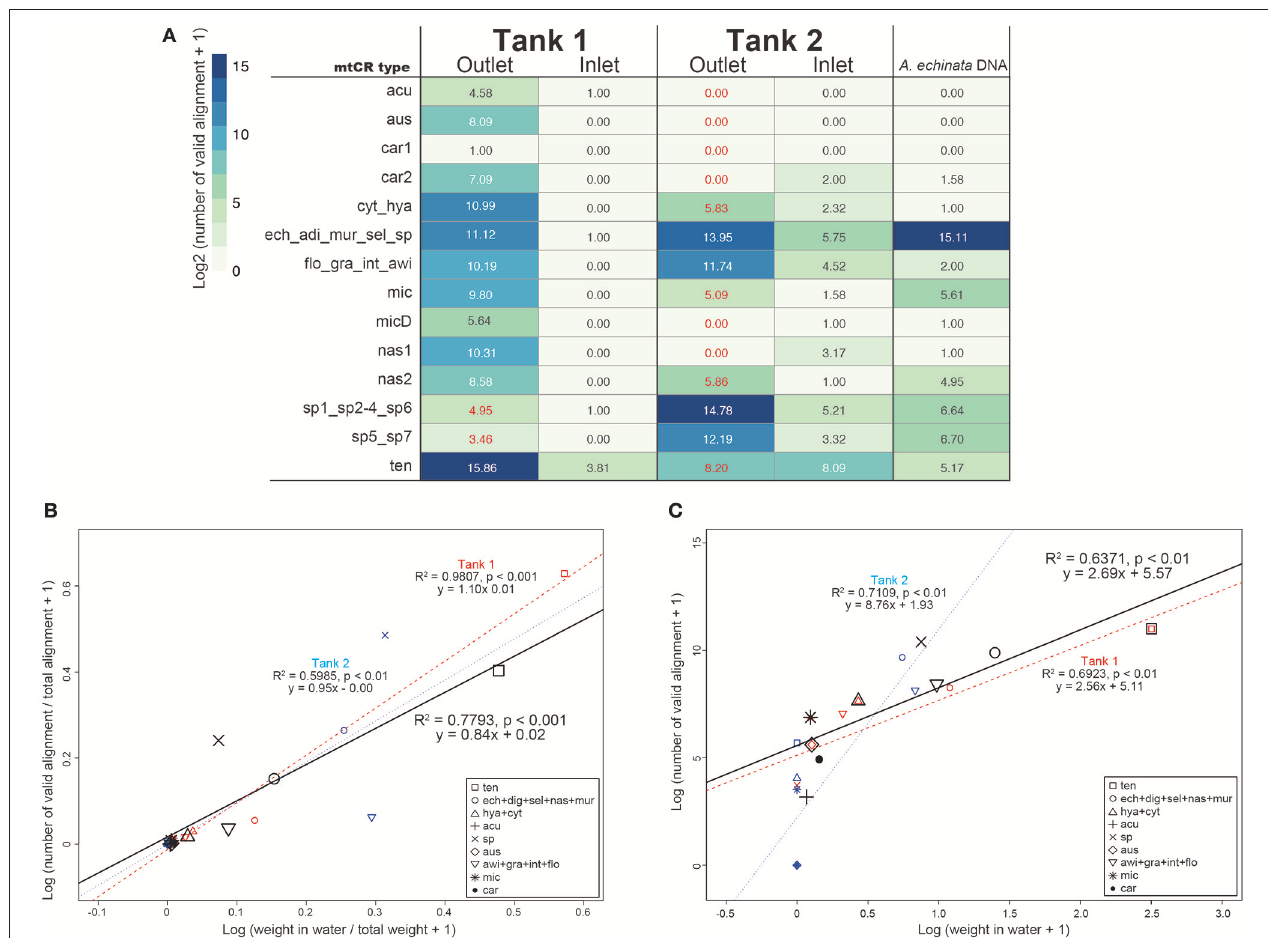
FIGURE 3 | (A) The number of Acropora mtCR types detected from eDNA and Acropora echinata DNA as a positive control. Numbers of valid alignment are shown at log2 scale and colored. IDs of the 300 bp flanking the RNS2 primer sequence in the mtCR are identical are concatenated. Numbers of mtCR types that did not exist in either Tank 1 or Tank 2 outlet are shown in red. (B) Log-transformed proportions of coral masses of each mtCR types to the total weights of the all corals in seawater in kg ( Table 1 ) and proportions of numbers of valid alignments from each mtCR type to the total numbers of alignments in both tanks, Tanks 1 and 2 shown in a scatter plot. (C) Log-transformed coral masses determined in seawater in kg ( Table 1 ) and numbers of sequence reads identified from each mtCR type in both tanks, Tanks 1 and 2 shown in a scatter plot. Dots and regression lines of both tanks in the scatter plot are shown in black, red, and blue, respectively. mtCR types from the same species or different species sharing same mtCR sequences are